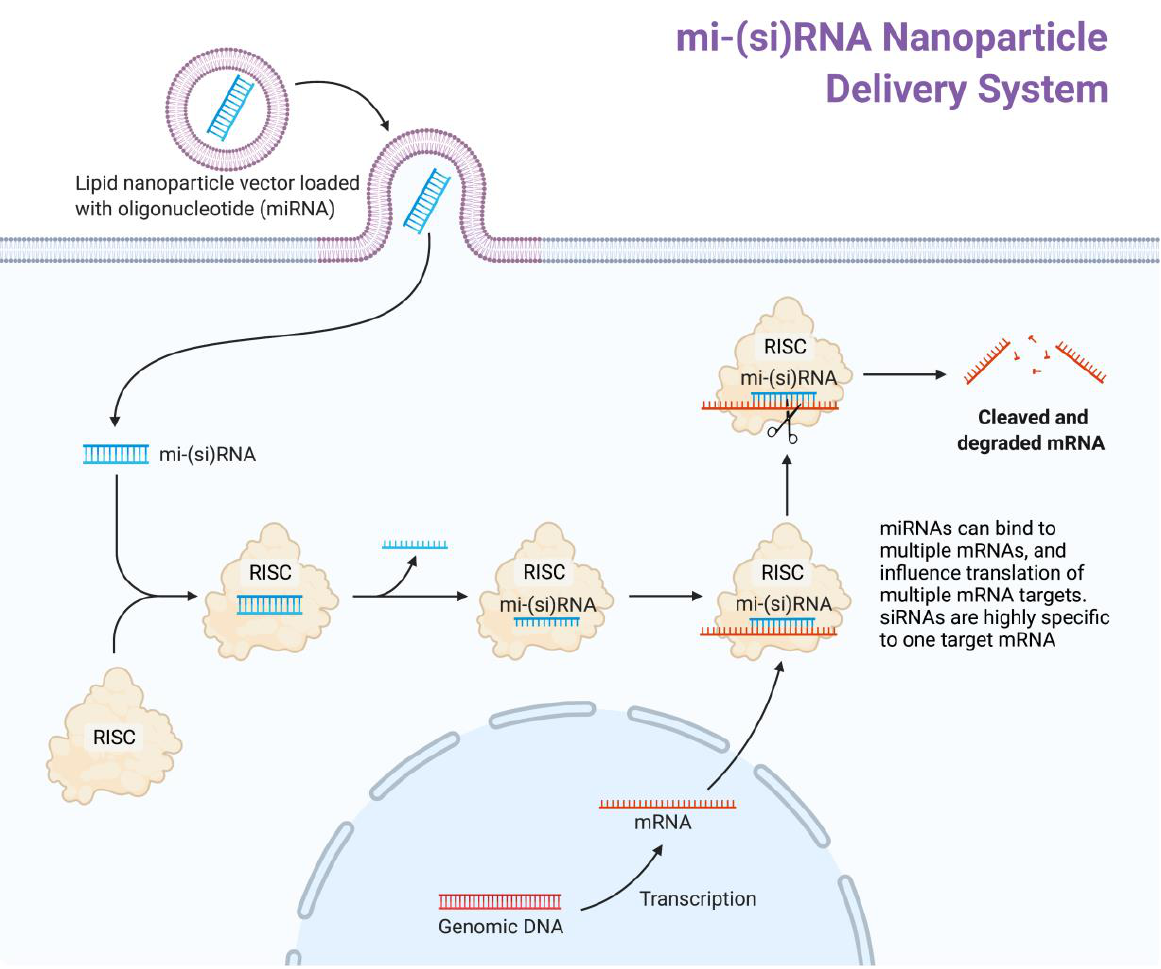
Figure 1. Concept of RNA-based drug delivery to target tissues. Mi-(si)-RNA is delivered by lipid particles, which can be incorporated by target cells via endocytosis. The delivered oligonucleotide can be taken up by the RNA-induced silencing complex (RISC), a ribonucleoprotein-complex. The introduced RNA serves as a template for RISC to bind a complementary intracellular mRNA transcript. Once a complementary mRNA binds to RISC, the complex induces cleaving and degradation of the target mRNA strand, effectively “silencing” mRNA expression of the